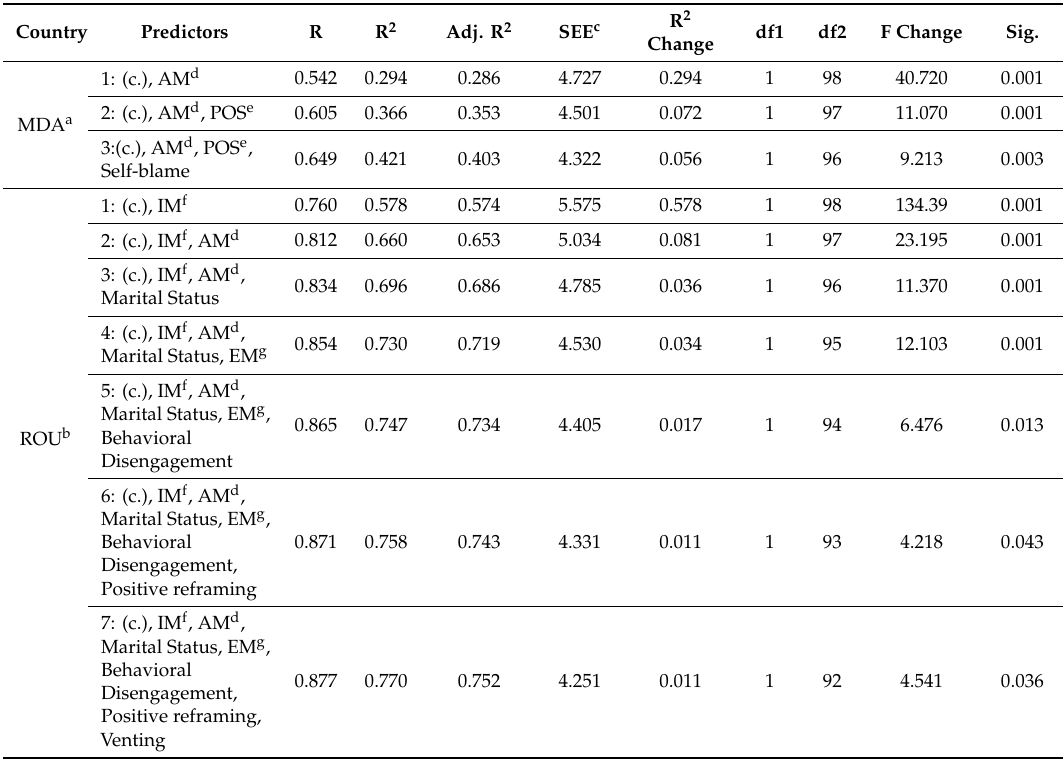
Table 5. Hierarchical linear regression models of personal ine ffi cacy in Moldova and